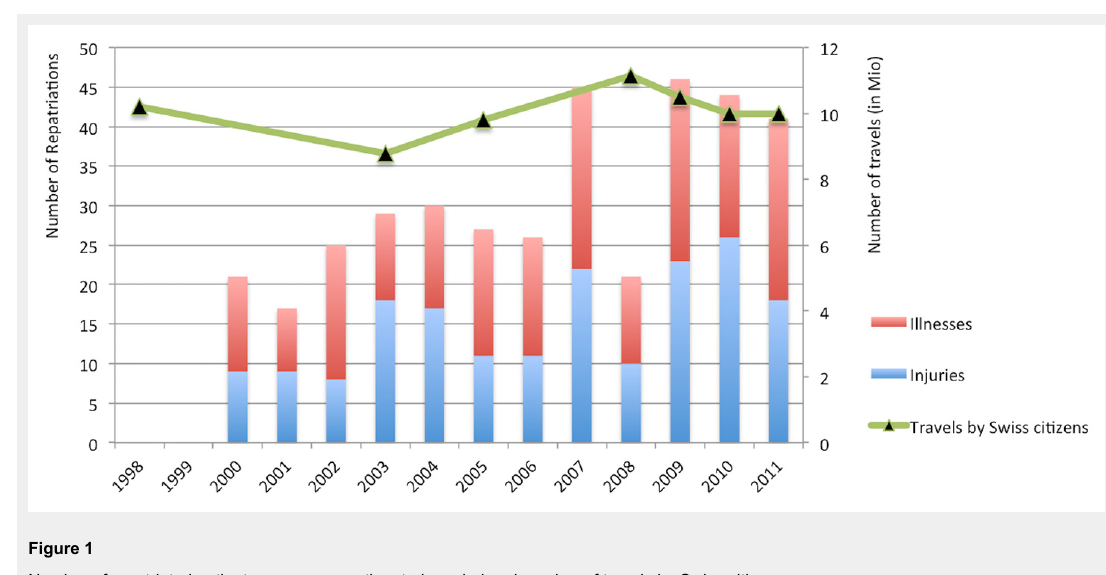
Number of repatriated patients per year over the study period and number of travels by Swiss citizens.